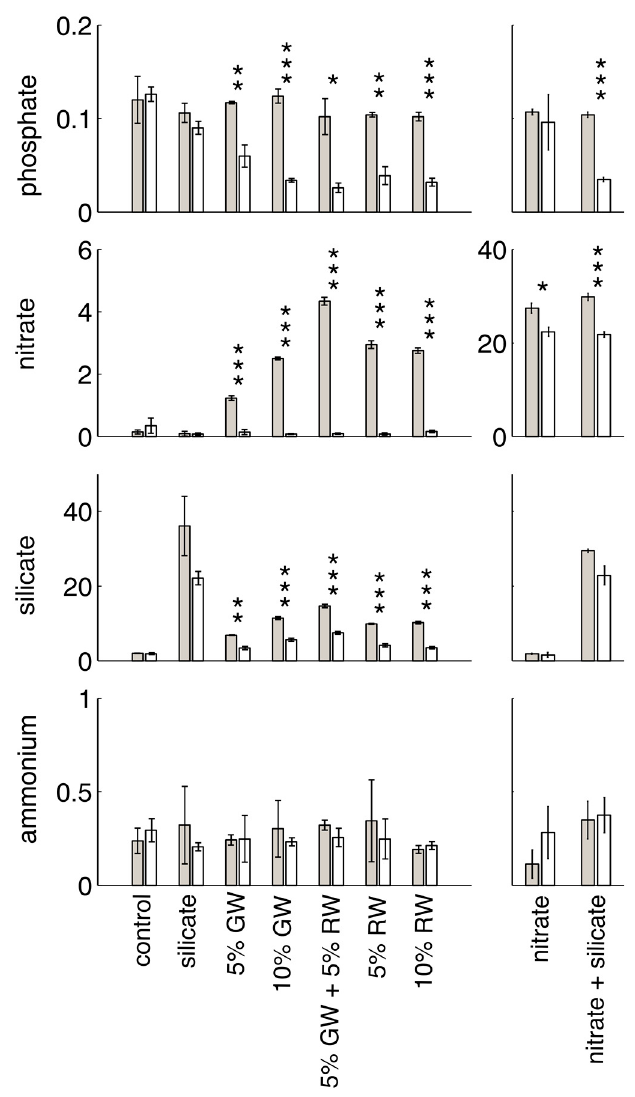
Figure 1. Beginning (gray bar) and final (white bar) nutrient concentrations for phosphate, nitrate, ammonium, and silicate. Stars note significant changes via t -test with p ≤ 0.10 = one star, p ≤ 0.05 = two stars, and p ≤ 0.01 = three stars. Nitrate and nitrate + silicate treatments are on a different scale for nitrate. Units are in μ M.